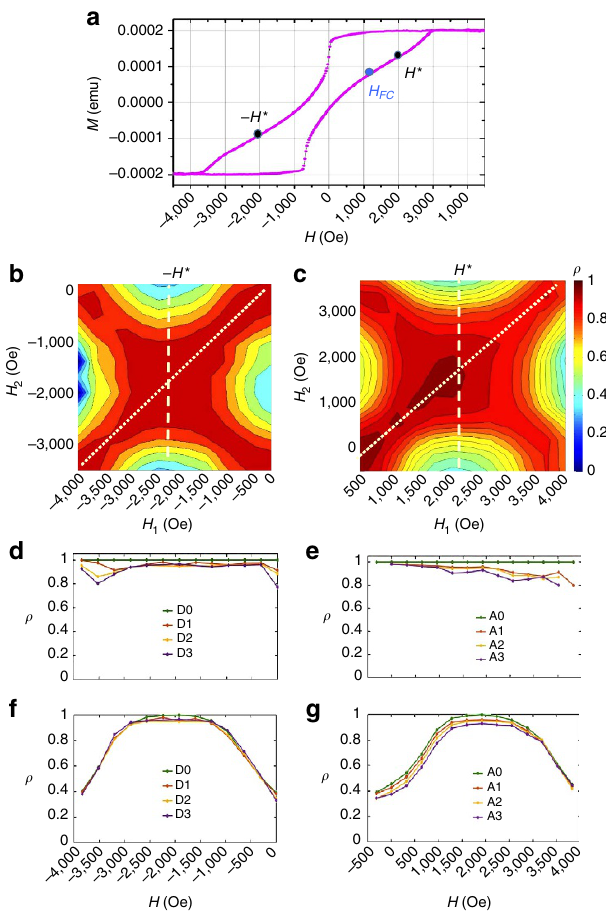
Figure 2 | Correlations maps and slices measured at 20K after FC under H FC ¼ 1,280Oe. ( a ) Magnetization curve M ( H ) at 20K after FC under H FC ¼ þ 1,280Oe, a field point indicated by the blue dot on the curve. ( b , c ) Correlation maps r ( H 1 , H 2 ) for one cycle separation (the correlation coefficient r is plotted in colour, where red is high and blue is low) measured along ( b ) the descending branch and ( c ) the ascending branch. ( d , e ) Diagonal slices, for which H 1 ¼ H 2 (dotted line). ( f , g ) Vertical slices through the maps at H 1 ¼ H* (dashed line). These graphs show slices through successive correlation maps, using the notation A0, A1 y D0, D1 and so on. In this notation, the letter A stands for the ascending branch, the letter D stands for the descending branch and the index corresponds to the number of cycles separating the two correlated images. For example, D3 shows correlation between two descending branches that are separated by three full cycles. In each map/slice, the plotted coefficient r is an average value over many cycles at a fixed cycle separation. (Fig. 2a). The resulting correlation maps for the descending branch (Fig. 2b) and for the ascending branch (Fig. 2c) show a very high correlation degree r approaching 100% in the central region. The high MDM extends over a wide plateau across the map, centred about H 1 ¼ H 2 ¼ H* B 2,000 Oe. This result persists throughout field cycling. Even after many cycles, the map is unchanged, as slices in Fig. 2d–g indicate. On the diagonal slices ( H 1 ¼ H 2 ), r is close to 100% over the entire range of field. On the vertical slices at H 1 ¼ H* , r reaches nearly 100% over a wide plateau extending from B 1,000 to 3,000 Oe. In that part of the magnetization loop, the magnetic domain pattern remains topologically close to the one at H* . When the diagonal slice is performed on the same cycle maps, it is expected that r ¼ 100%, as, by definition, speckle patterns are correlated with themselves,